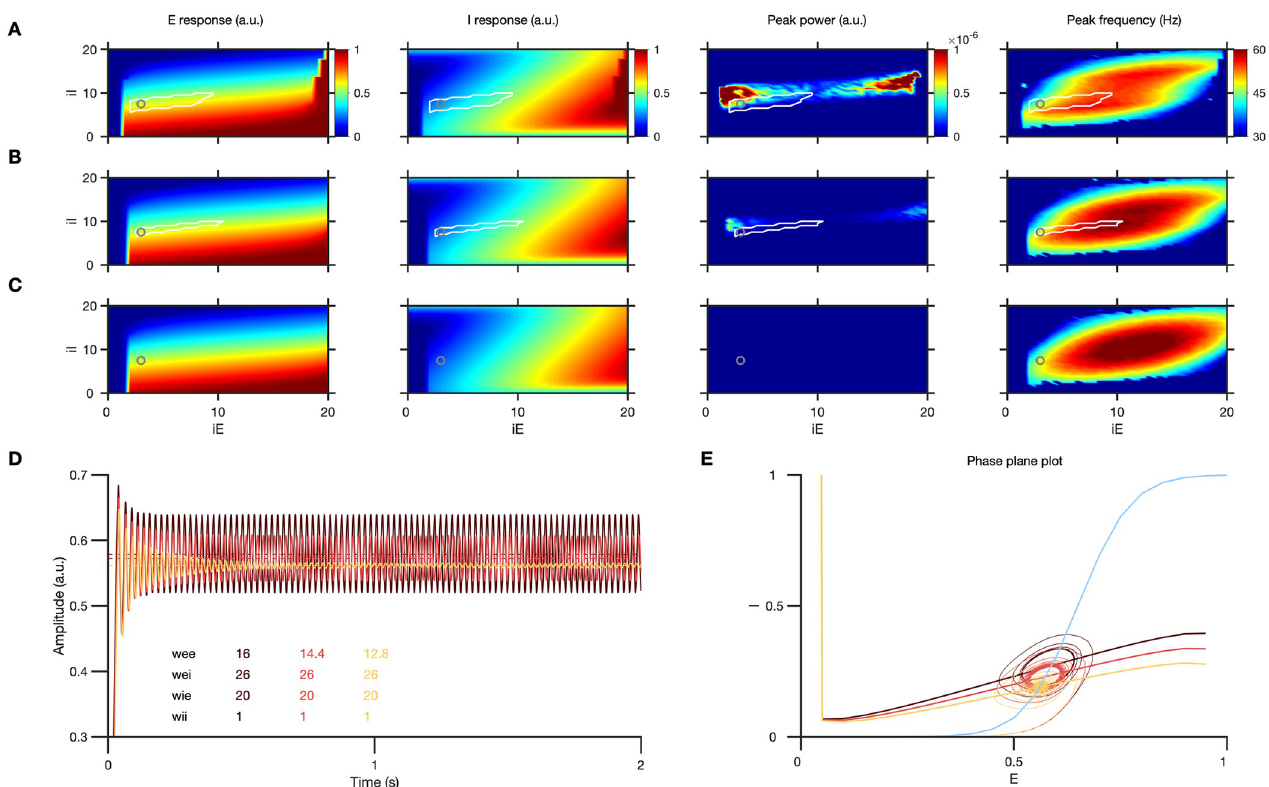
Fig 8. Effect of stimulus discontinuity in the model. (A) Left to right: E and I response, peak power in the gamma range and the corresponding peak frequency, for different values if iE and iI for the default model weights. (B) and (C) are the corresponding results for modified networks with only wee reduced by 10% and 20%, respectively, as excitatory LR inputs to E decrease due to discontinuity (weights indicated in (D)). White lines indicate the sublinear E and superlinear I response regime where increase in iI causes gamma amplitude to increase and frequency to decrease (this regime is absent in case 3). Oscillations weaken drastically in the network from case 1 to 2 and 3, even when the mean E and I responses do not change as much. (D) E response in the above 3 cases for iE = 3, iI = 7.5 (marked by the gray circle). (E) Phase-plane analysis showing the effect of varying wee on the E and I nullclines. Only the E nullcline shifts in these 3 cases, while I nullcline (light blue) remains the same. Figure data are located at https://doi.org/10.5281/zenodo.6523772. LR, lateral